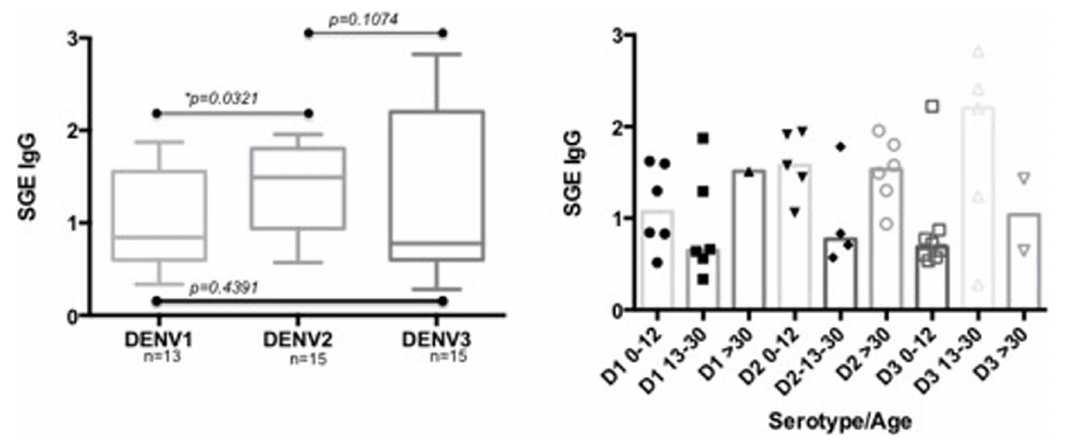
Figure 4. Concentration of anti- Ae. aegypti SGE antibodies according to the DENV serotype in participants from Los Patios diagnosed by RT-PCR. Figure also represents the distribution of the different SGE-antibody concentrations for each DENV serotype by age group. Statistical significance (*) p , 0.05.